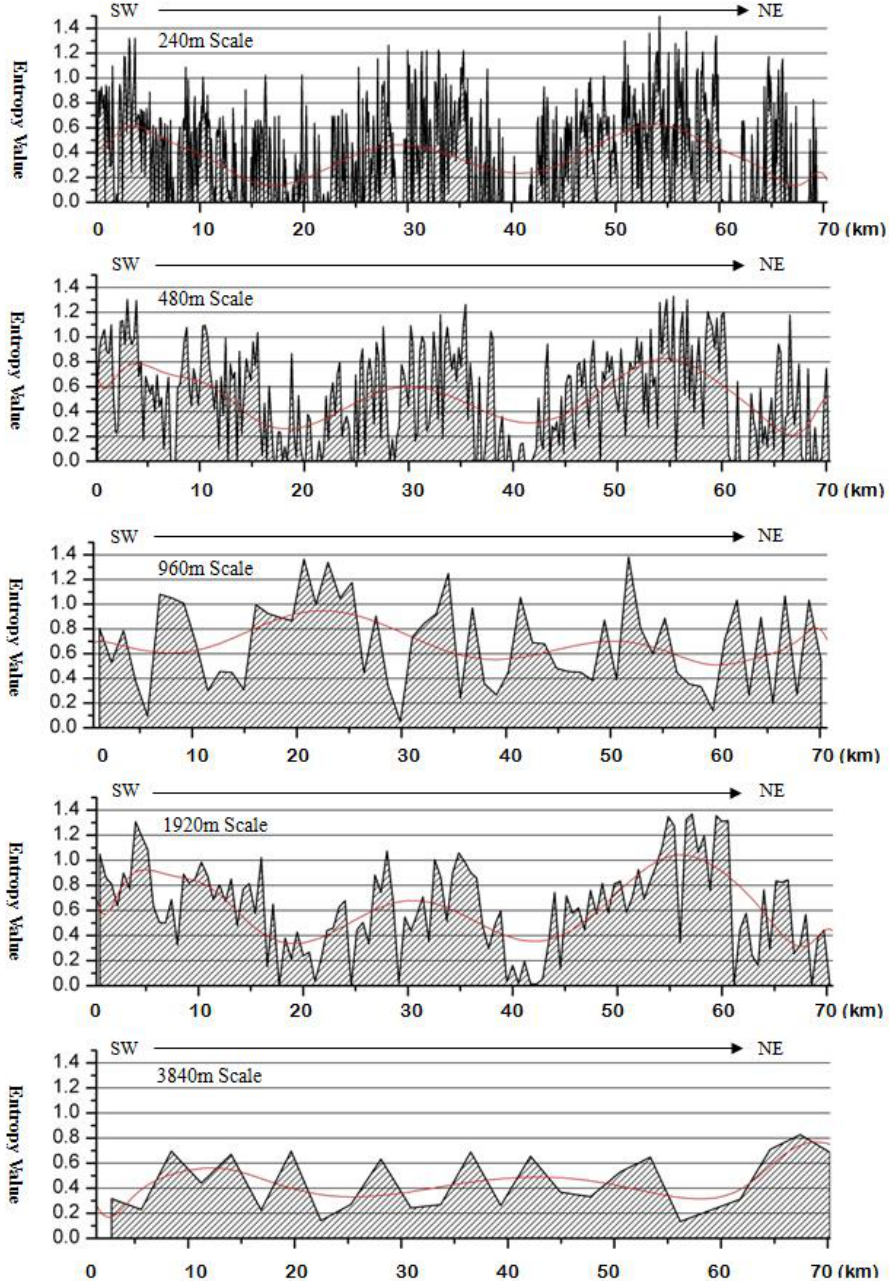
Figure 4. The information entropy value variation at different scales (240 m, 480 m, 960 m, 1920 m, 3840 m).